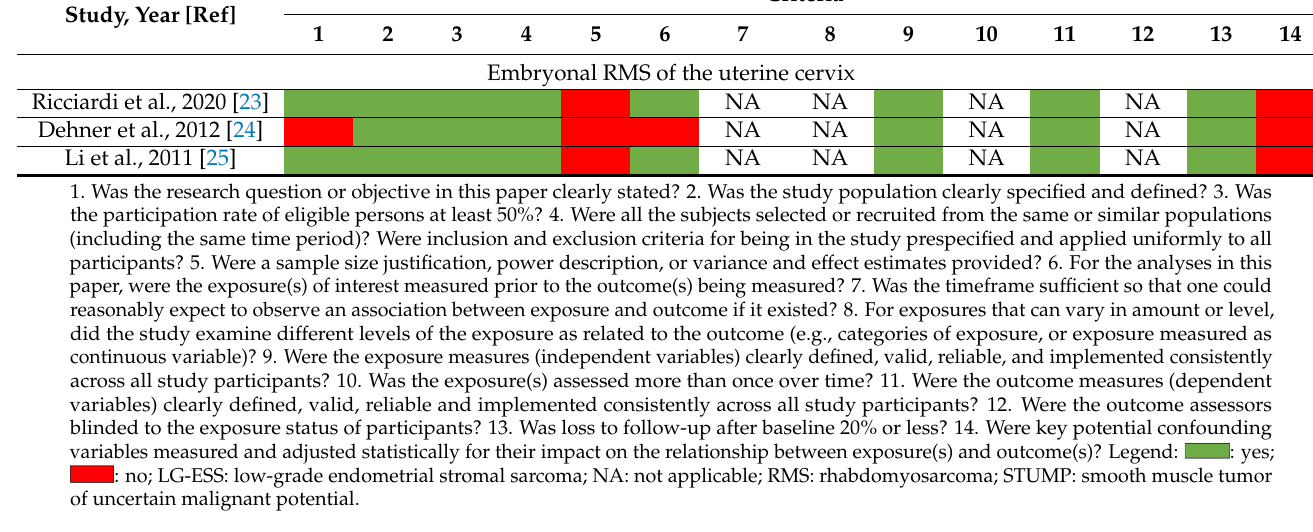
Table 2. Quality assessment of case series and case